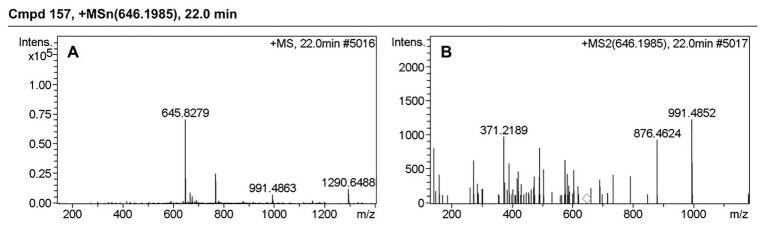
MS and MS/MS spectrum of IWDSTDALELK. (A) MS spectrum of IWDSTDALELK. (B) MS/MS spectrum of IWDSTDALELK.